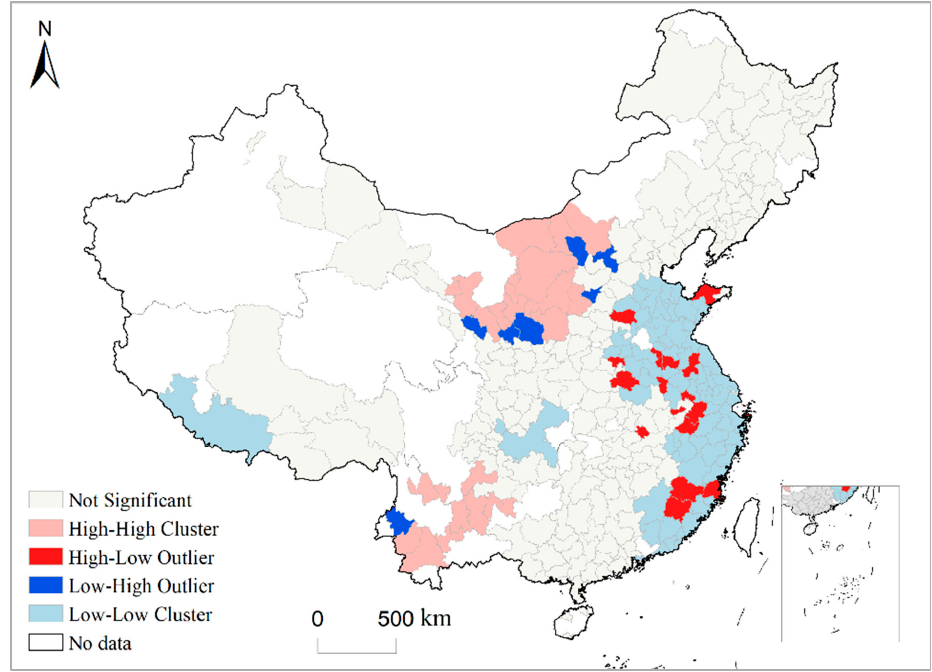
Figure 5. Local clustering of urban